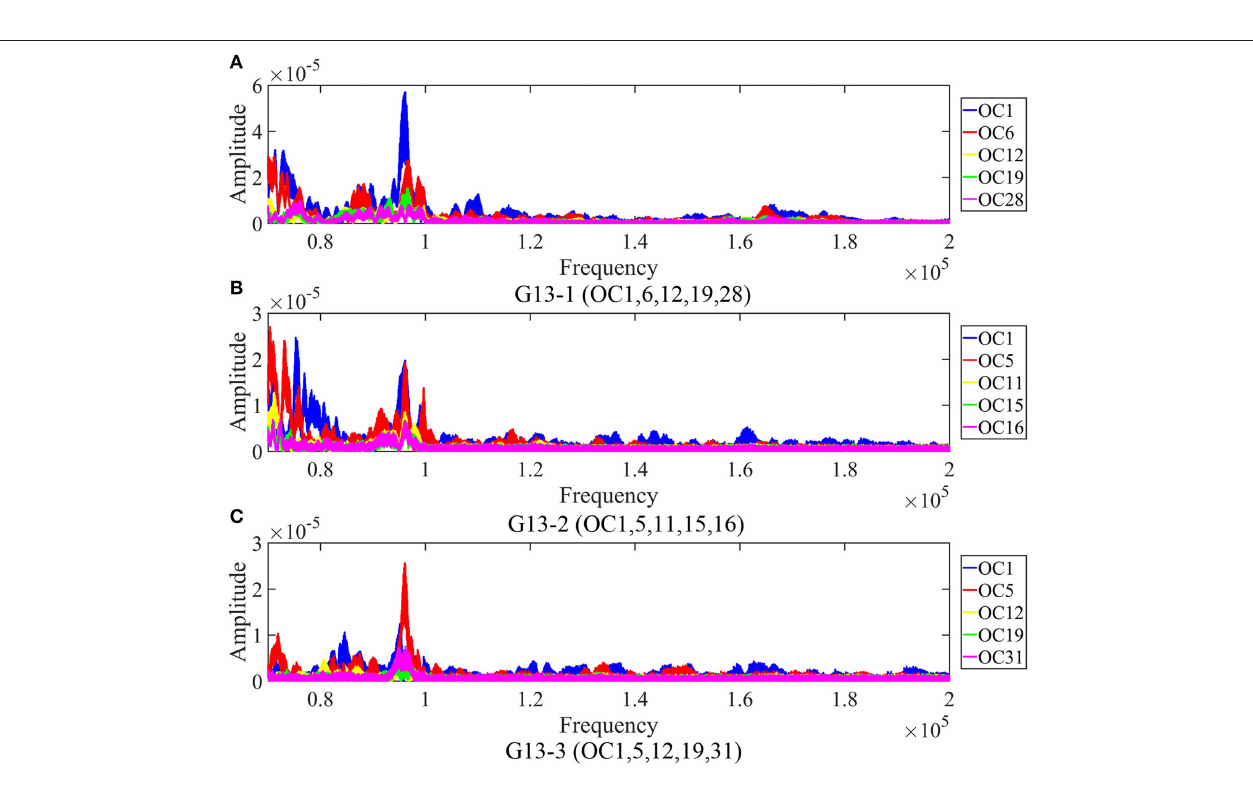
Frontiers in Materials |